Question: Is the quantity shown trending increasing or decreasing?
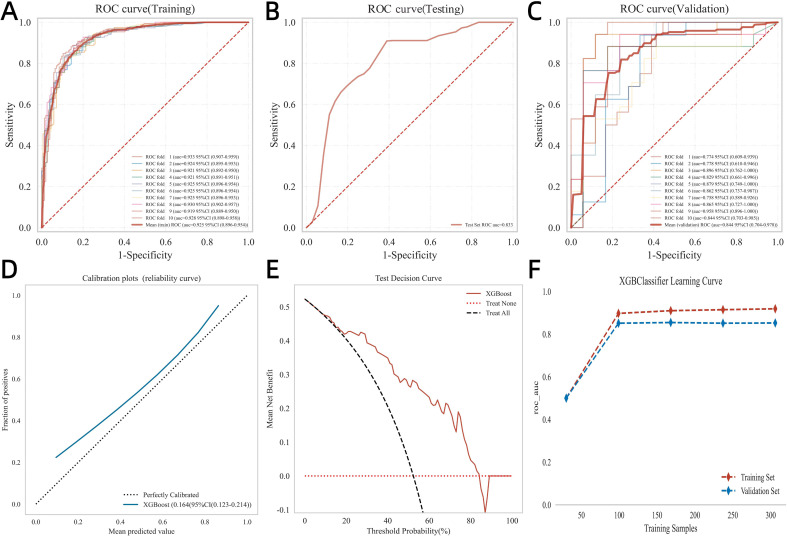
Answer: increasing